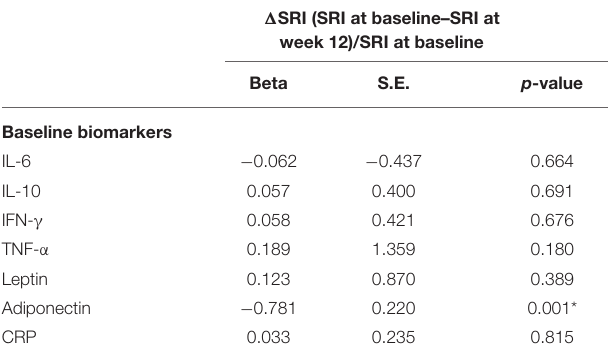
TABLE 3C | Multivariable model in patients with PD ( n =